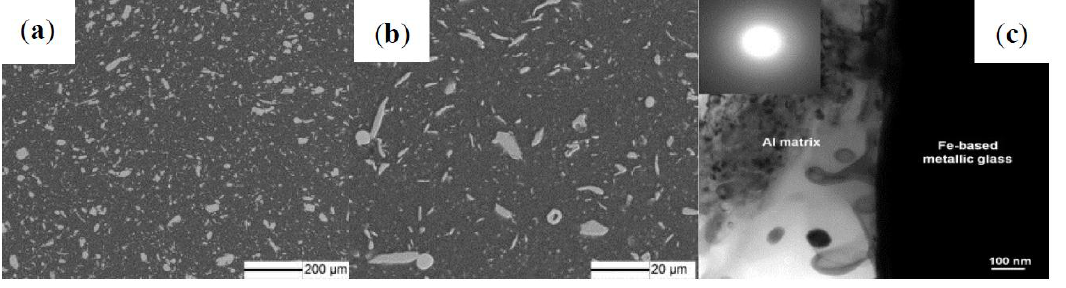
Figure 10. SEM micrographs of Al 2024 alloy reinforced with Fe based metallic